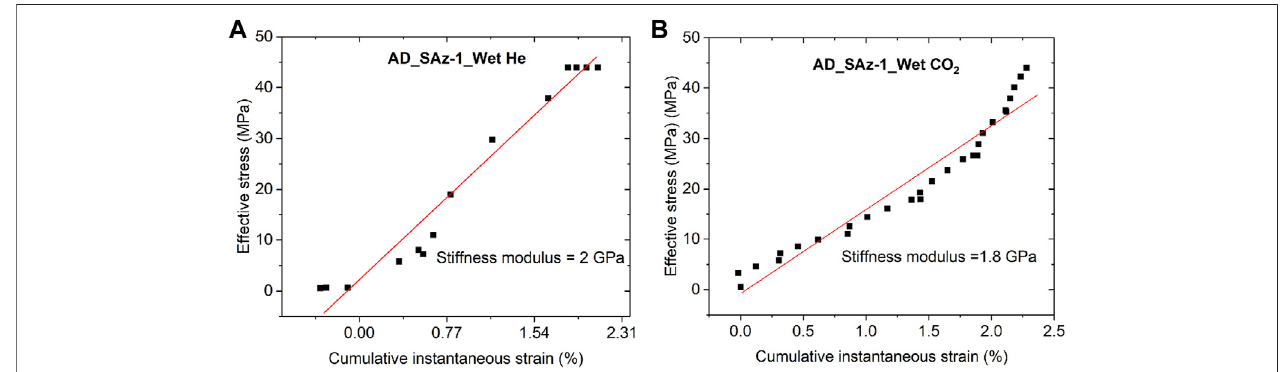
FIGURE 8 | Cumulative instantaneous strain developed in the AD SAz-1 sample during Stage 2 stress stepping using (A) wet He and (B) wet CO 2 as pore fl uid. Best linear fi ts yield similar values of axial stiffness for both fl uids used.